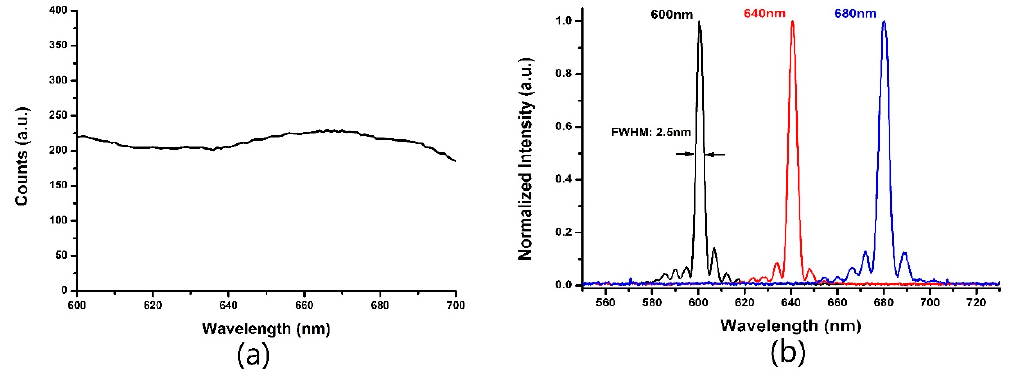
Figure 3. ( a ) The spectrum of white light laser at 600–700 nm; ( b ) The monochromatic light spectra filtered by AOTF. The center wavelengths are 600 nm/640 nm/680 nm.